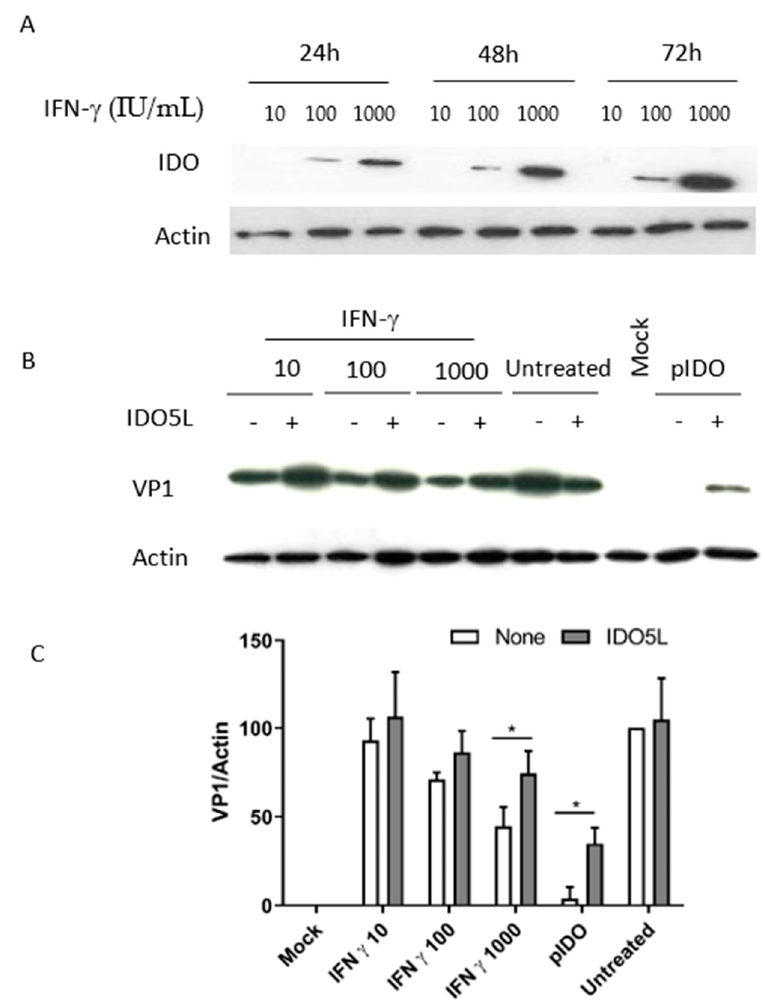
Figure 6. Antiviral effect of IFN-gamma and IDO with pLXSN-hTERT retroviral transfection (RPTE/TERT1) cells. RPTE/TERT1 cells were treated with IFN-gamma and collected after 24, 48 or 72 h. ( A ) Levels of IDO and actin expression were monitored by Western blotting. Infected cells were treated with 10, 100 and 1000 IU/mL IFN-gamma or transfected with a plasmid encoding human IDO1 . IDO5L was added at the same time as IFN treatment or transfection. Total cellular proteins were harvested 3 days after infection. ( B ) VP1 and actin were detected by Western blotting. ( C ) Densitometric analysis of VP1, normalized against actin. The results in C represent the mean ± SD of three independent protein samples per condition. “Mock” corresponds to non-infected cells and “Untreated” corresponds to cells infected in the absence of IFN. * p < 0.05.